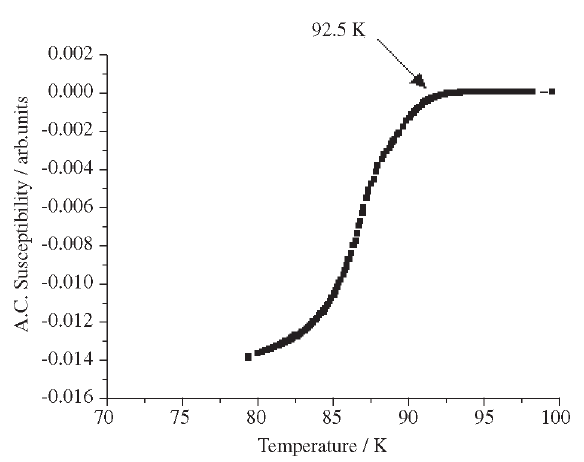
Figure 7. Temperature dependence of magnetic susceptibility for